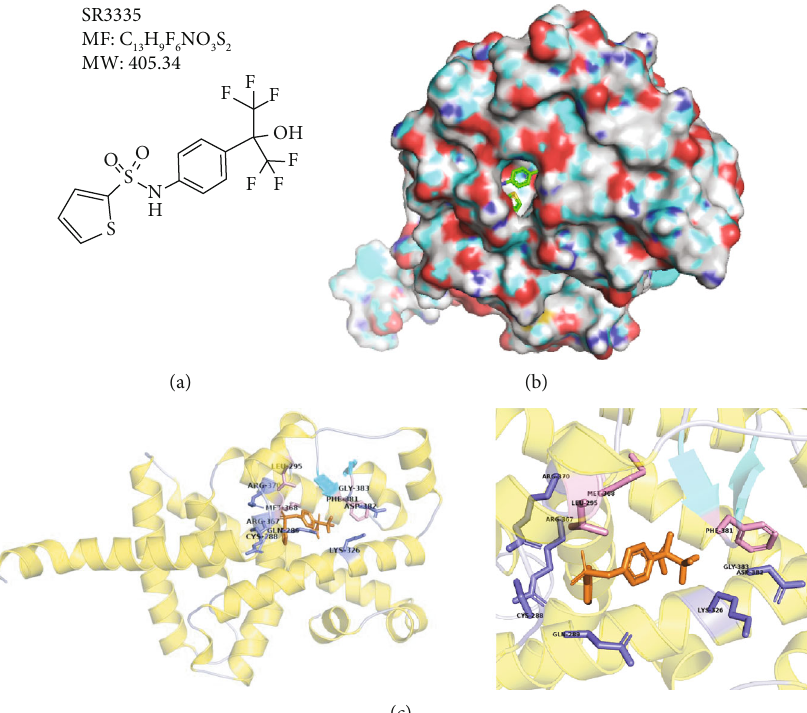
Figure 2: The molecular structure and predicted interaction with the ROR α protein. (a) Chemical structure of SR3335. (b) The molecular structure of the ROR α protein. The pocket for ligand binding is shown. (c) Molecular docking of SR3335 and ROR α indicating high- a ffi nity interaction between SR3335 and adjacent amino acid residue ( distance ≤ 2 : 5 Å